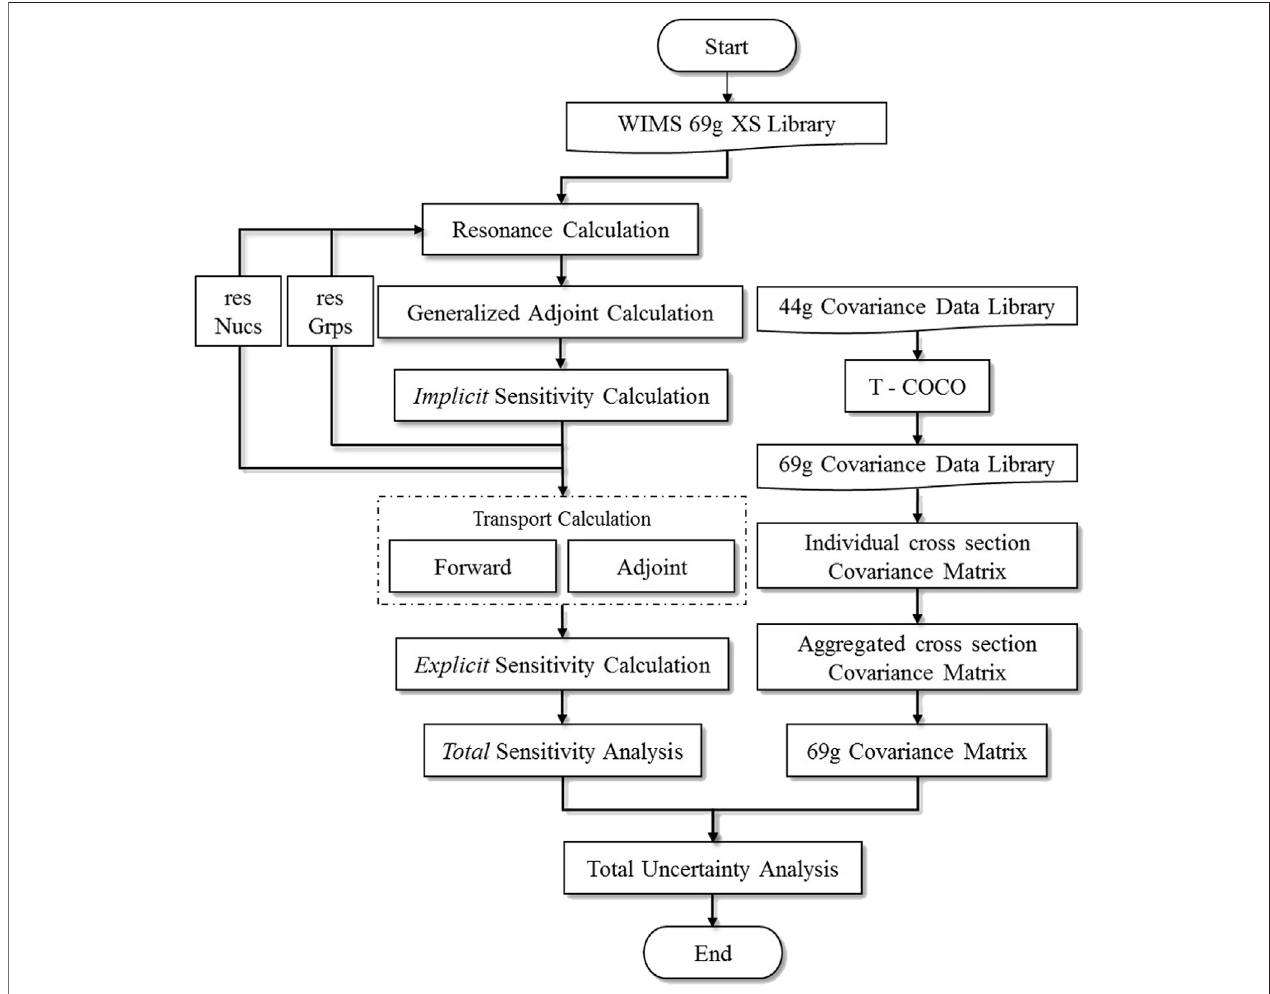
FIGURE 1 | Flowchart of the total sensitivity and uncertainty analysis.